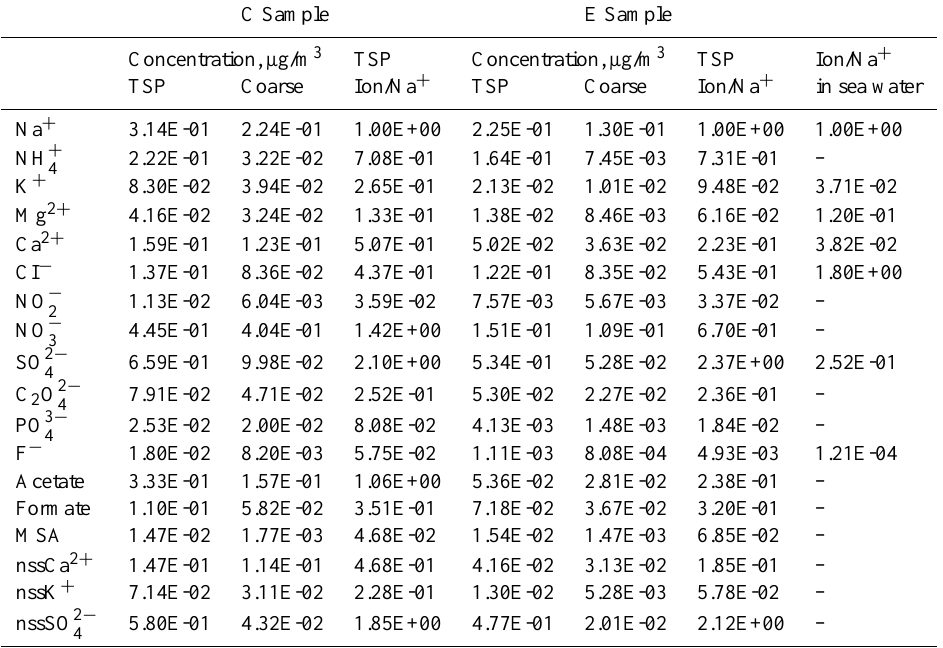
Table 4. Ionic species concentrations of all ions detected in Ion Chromatography analysis, with the mass ratios of these ions to Na + (Coarse fraction is the sum of species concentrations found at stages ≥